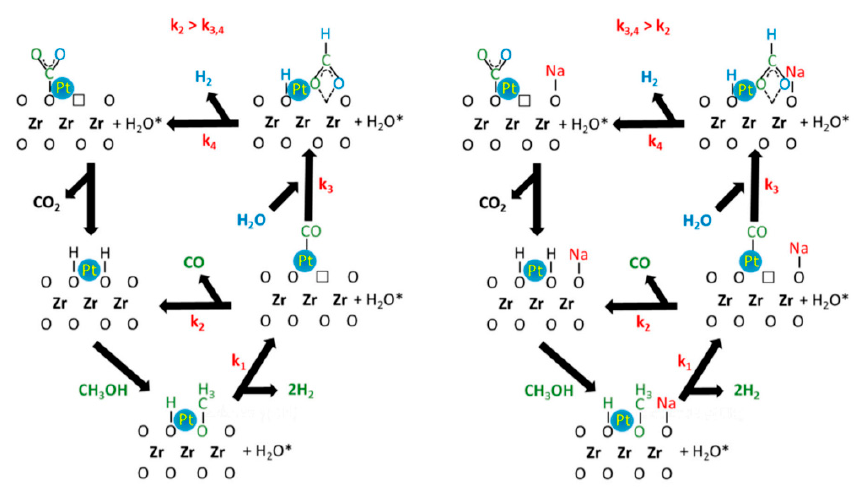
Figure 13. Proposed MSR pathway on undoped Pt/YSZ ( right ) and Na-doped Pt/YSZ ( left ) [187].